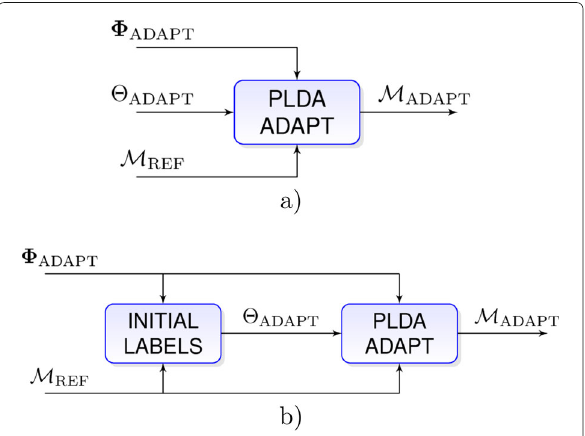
Fig. 7 Schematic for the a supervised and b unsupervised adaptation. M REF represents the source model and (cid:6) (cid:4) ADAPT and ADAPT are the i-vectors and labels to adapt,